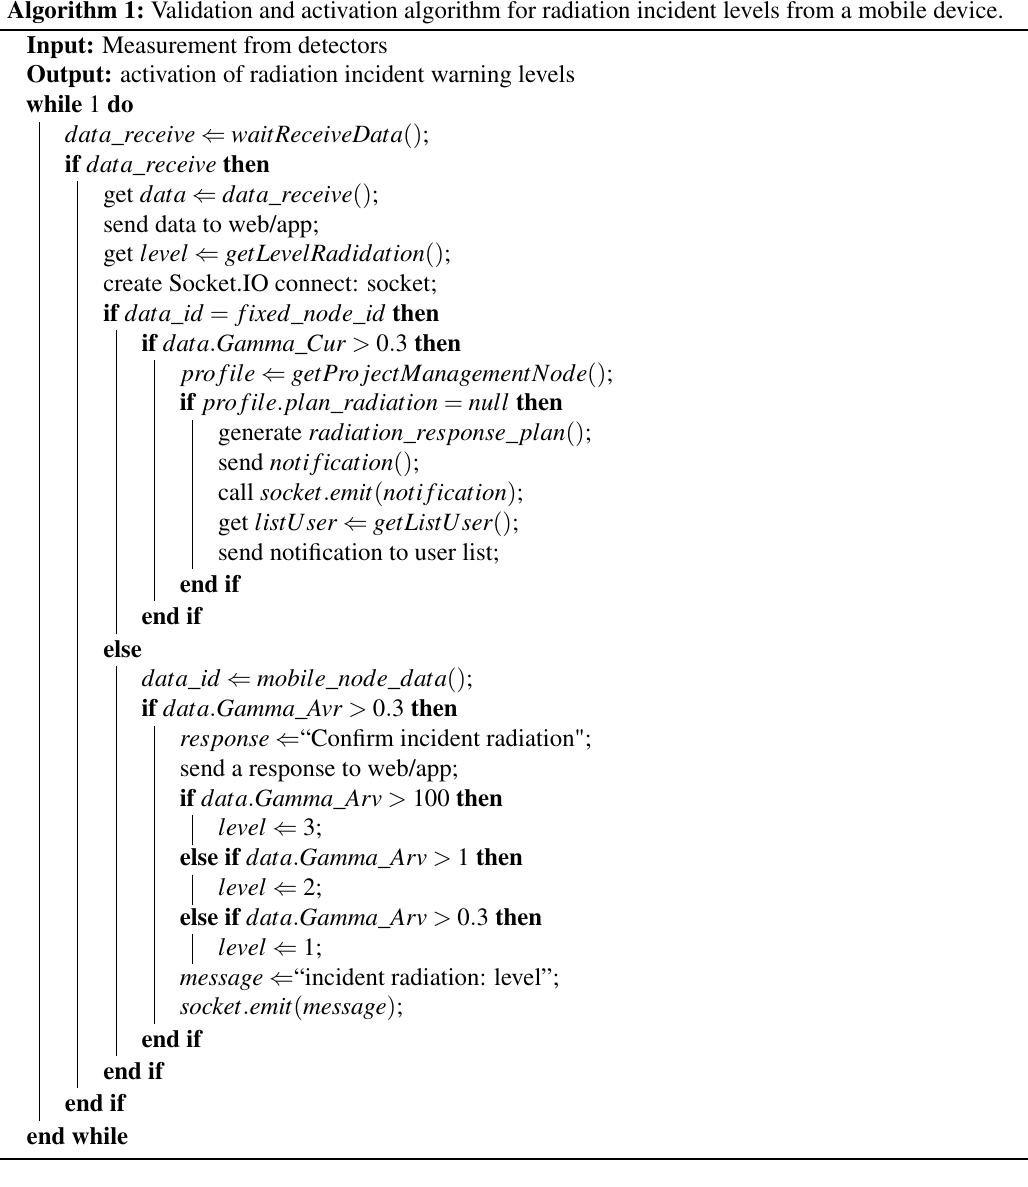
Algorithm 1: Validation and activation algorithm for radiation incident levels from a mobile